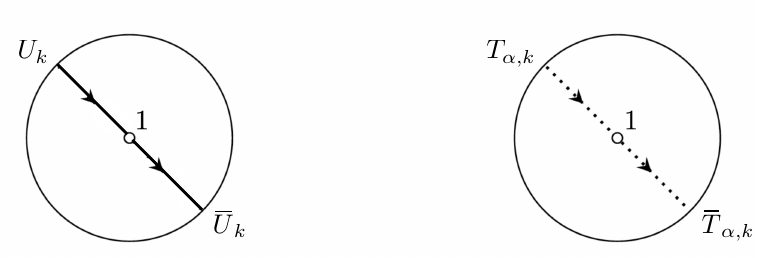
Figure 2 . The 2-point effective Witten-like diagrams that pictorially represent the untwisted (left) and twisted (right) correlators in (6.3). The circle represents the space where the gauge theory operators are inserted. Our conventions are such that it yields the factor MN 2 . The full and dotted oriented lines represent the “propagators” of the untwisted and twisted modes, respectively, and the arrows distinguish between the chiral and anti-chiral ones. Finally, the open dot in the middle represents the quadratic vertex which, with the coefficients w simply 1. The correlators (6.3) are thus given by the product of the global factor MN 2 times 1.